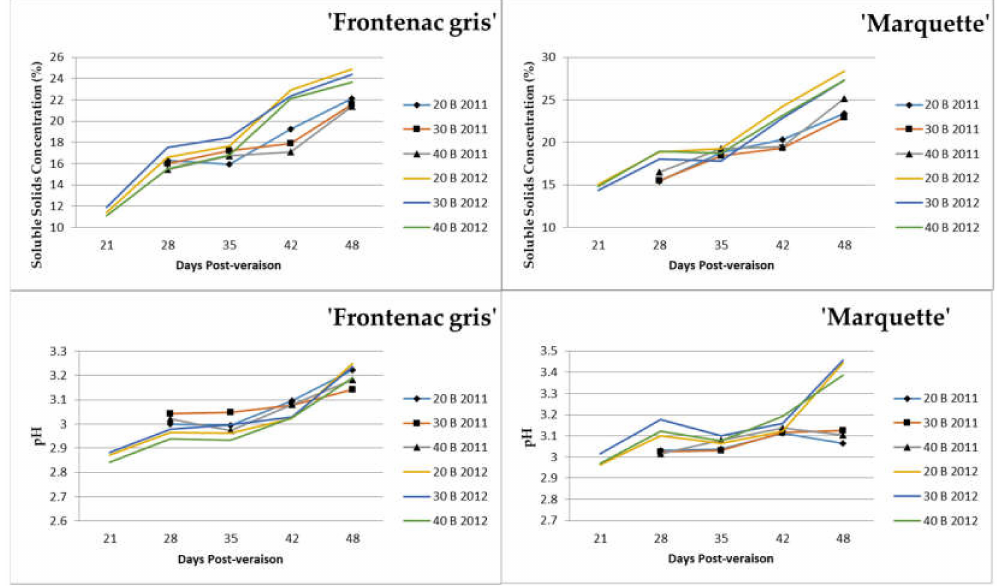
Figure 3. Weekly fruit sampling to determine soluble solid concentration and pH as parameters of fruit maturity for two V. riparia -based cultivars averaged over fruit-zone leaf removal levels and locations; z Abbreviation B = number of primary buds